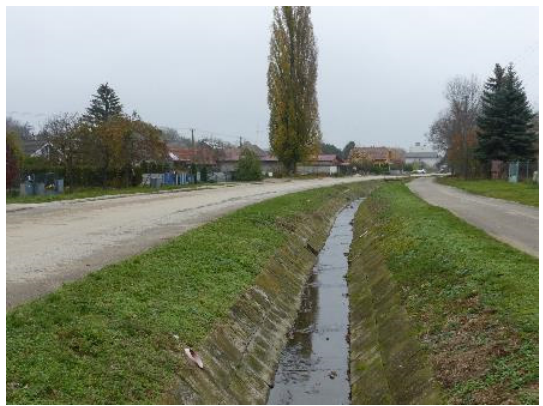
Figure 2. Dolný Lopašov community (Moyzeová, 2020) .